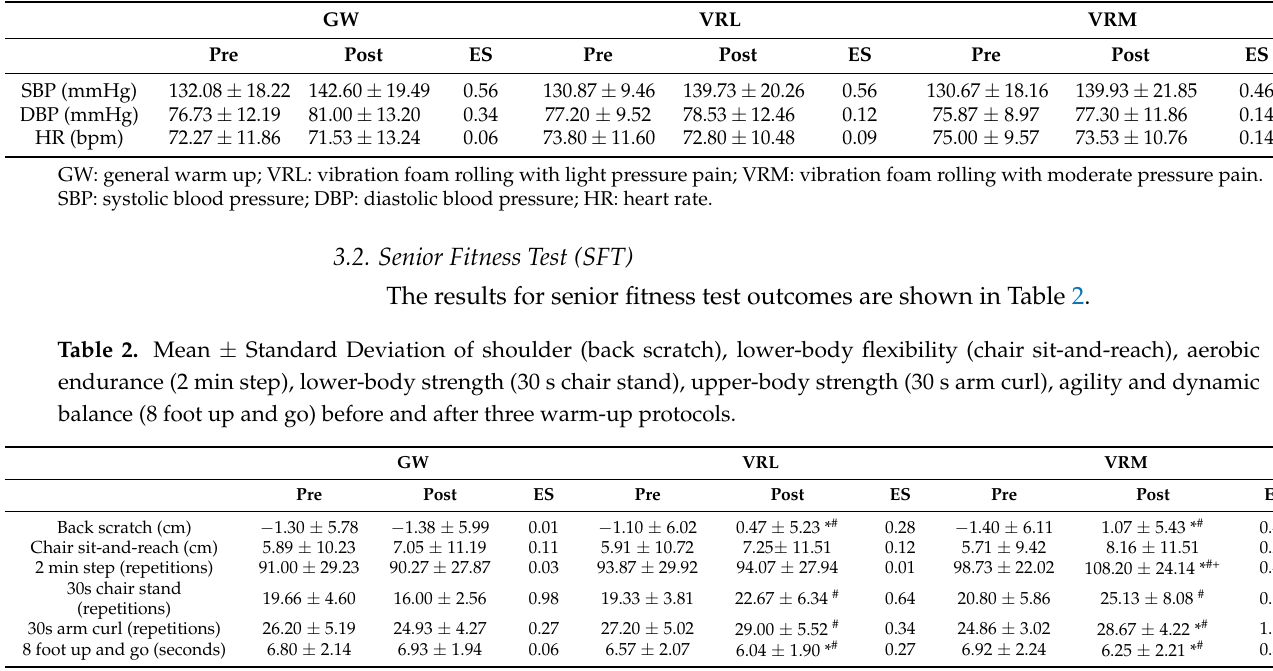
Table 1. Mean ± Standard Deviation of systolic blood pressure, diastolic blood pressure, heart rate following three warm-up protocols. GW